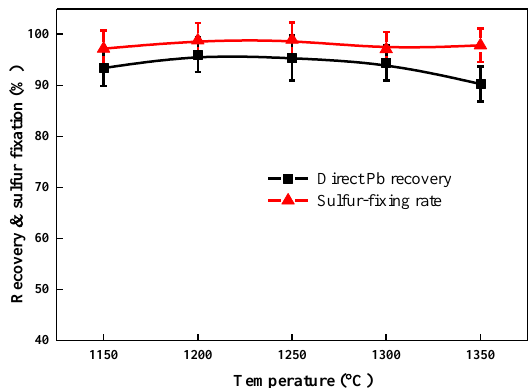
Figure 7. The effects of treatment temperature on lead recovery and sulfur fixation. (W lead Figure7. Thee ff ectsoftreatmenttemperatureonleadrecoveryandsulfurfixation. (W lead paste :W Na2CO3 : W pyrite cinder :W coke = 200:8:50:24 g, FeO / SiO 2 = 1.3, CaO / SiO 2 = 0.4, 2 paste :W Na2CO3 :W pyrite cinder :W coke = 200:8:50:24 g, FeO/SiO 2 = 1.3, CaO/SiO 2 = 0.4, 2 h).